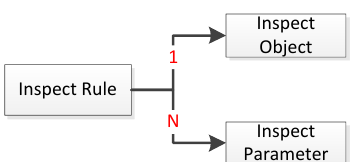
Figure 2 Inspect Rule Under Achievement Dimension